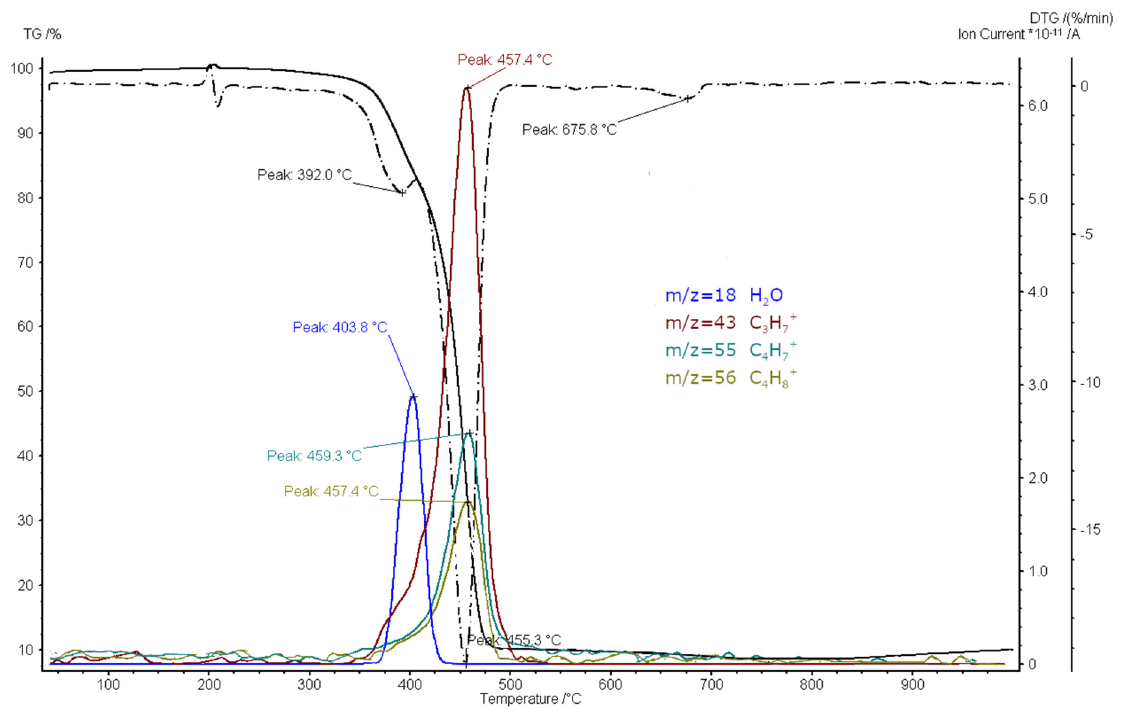
Figure 6. TG-DTG curves with curves of MS ion currents of volatile fraction ( m / z 18, 43, 55, 56).